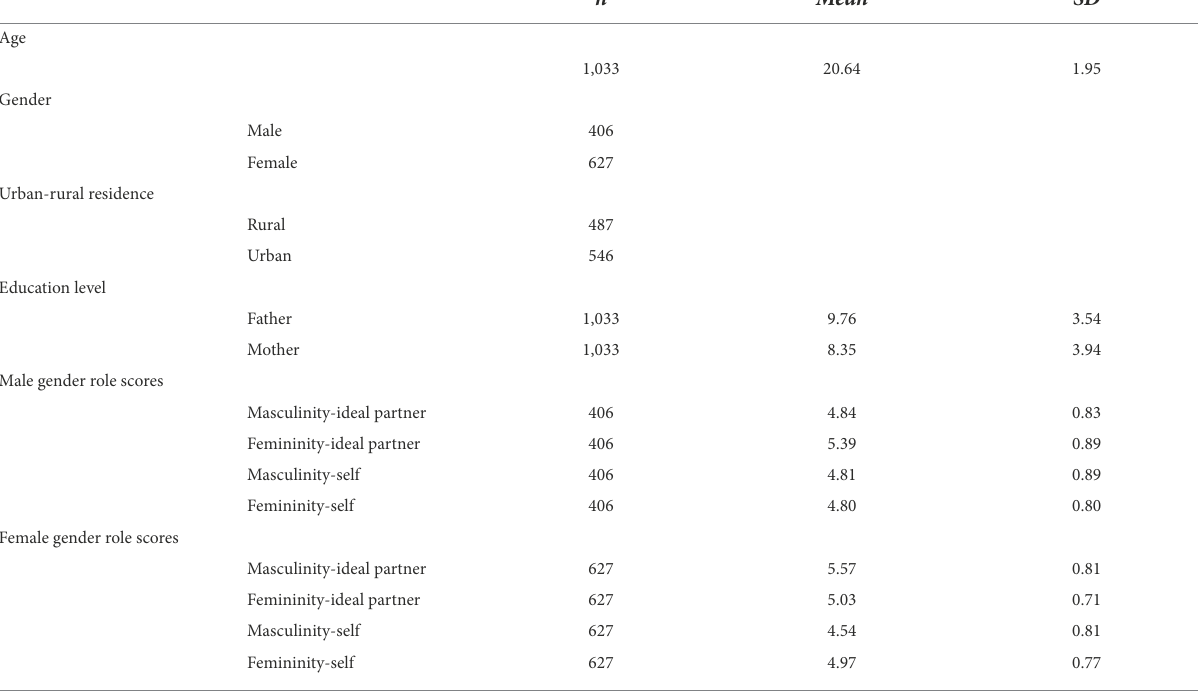
TABLE 1 Characteristics of participants.